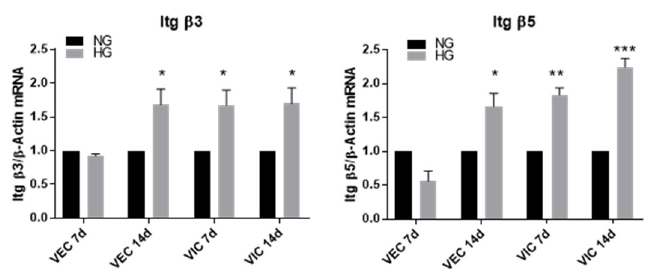
Figure 5. Integrin gene expression in valvular cells (VEC and VIC) in the 3D model exposed to NG or HG concentrations of glucose for 7 and 14 days. Cells were isolated from 3D constructs after 7 and 14 days and investigated by quantitative polymerase chain reaction (qPCR). The results are presented as fold change versus NG condition for every type of cell and investigated time. N = 3, * p < 0.5, ** p < 0.01, *** p < 0.001.